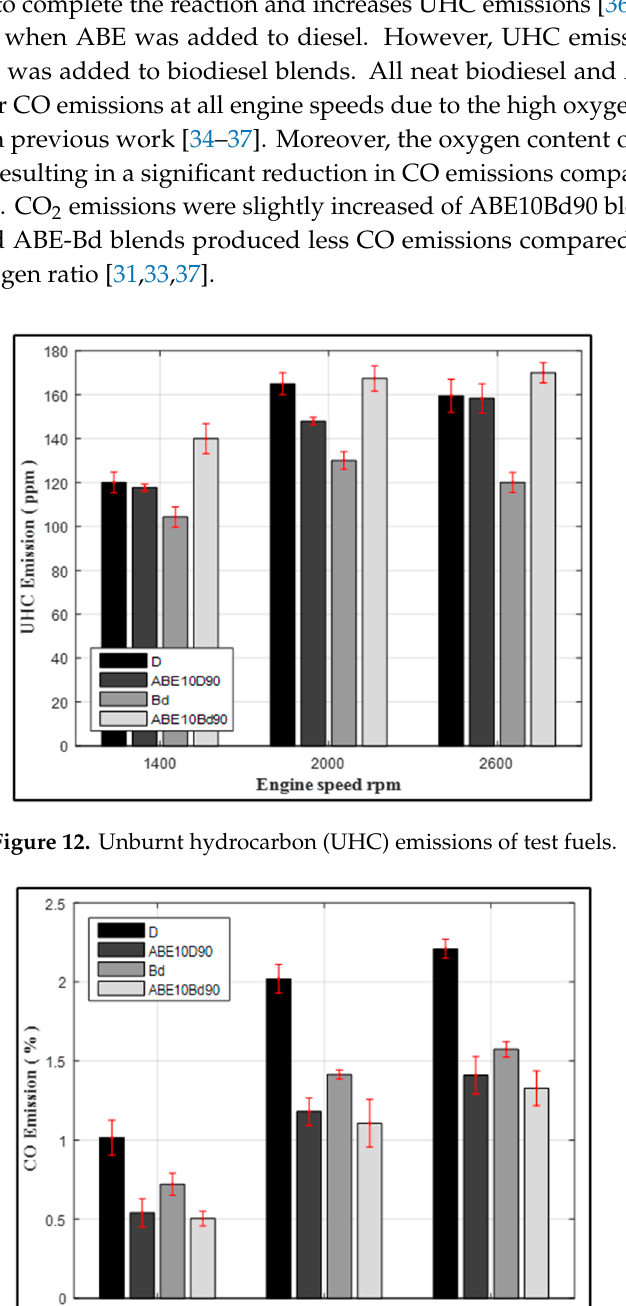
Figure 14. CO 2 emissions of test fuels.